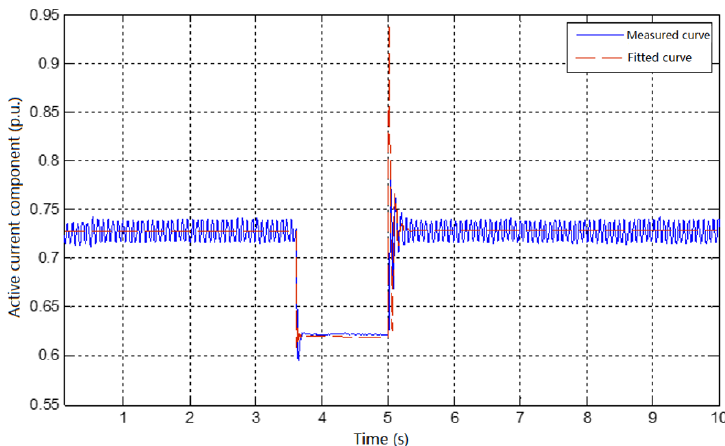
Table 3. Parameter identification results under large disturbance of grid voltage.